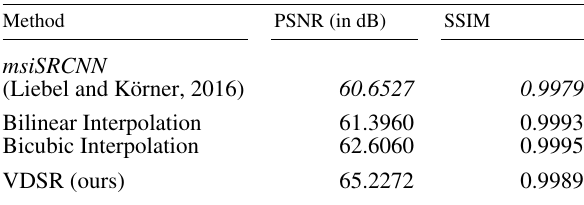
Table 1. Comparison of quantitative results for up-scaling using different methods on an unseen test dataset (dataset mean). Note that the msiSRCNN was scored on a different test set.